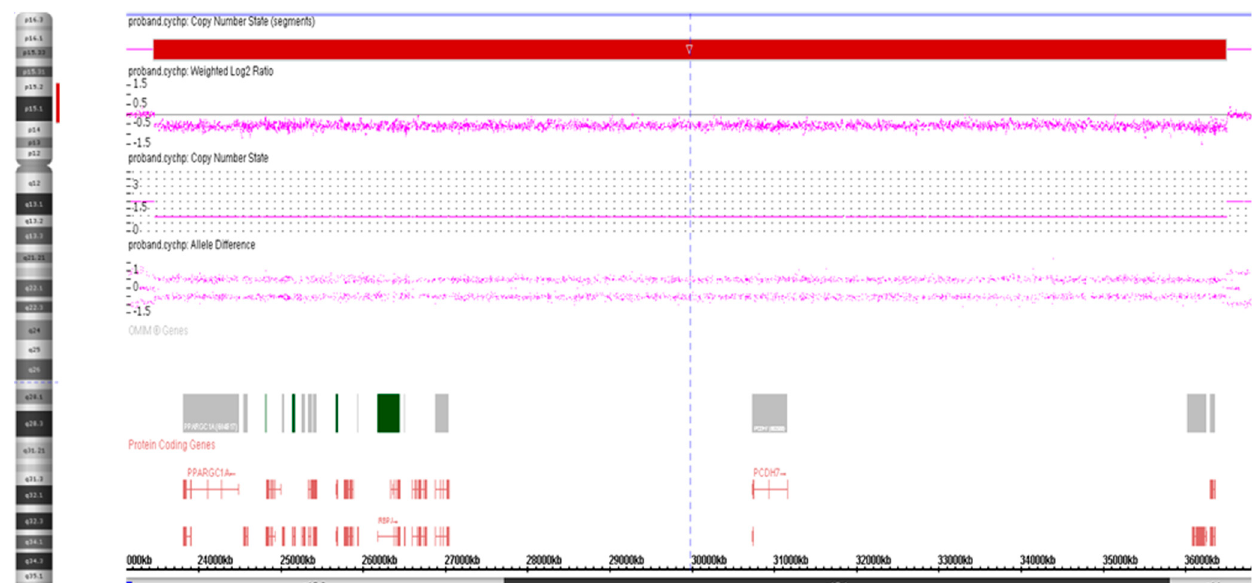
Figure 2. Whole-genome CMA analysis on uncultured peripheral blood lymphocytes of the proband. An 13.4-Mb deletion at 4p15.2-p14 [ISCN arr[GRCh37] 4p15.2-p14(23443552_36483601)×1].